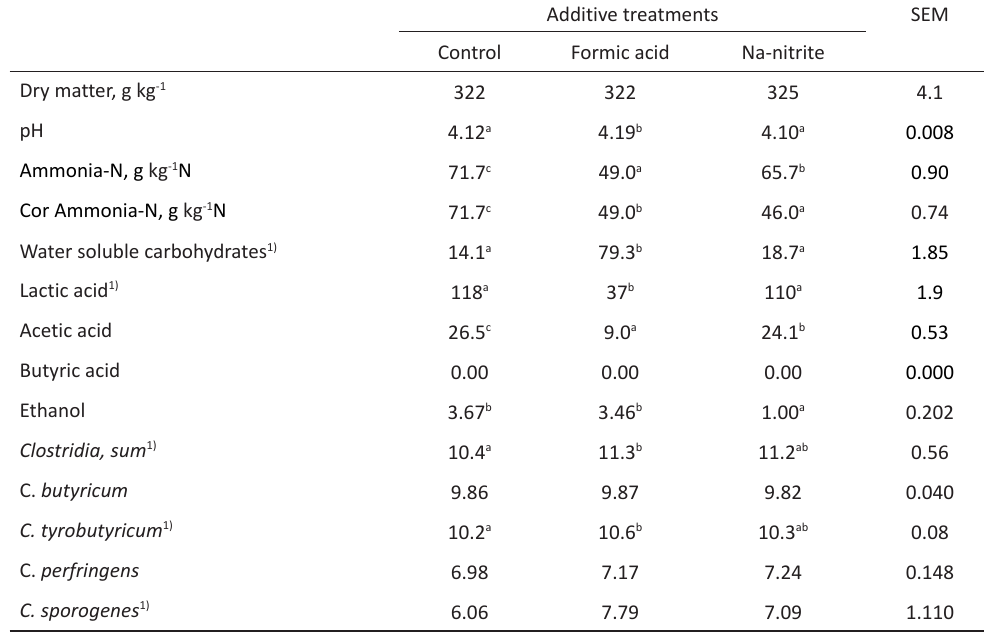
Table 4. The effect of additive treatment on wilted red clover-based silage fermentation quality (g kg -1 dry matter, if not otherwise stated) and number of clostridia as log copies g -1 fresh matter (n = 4) (experiment